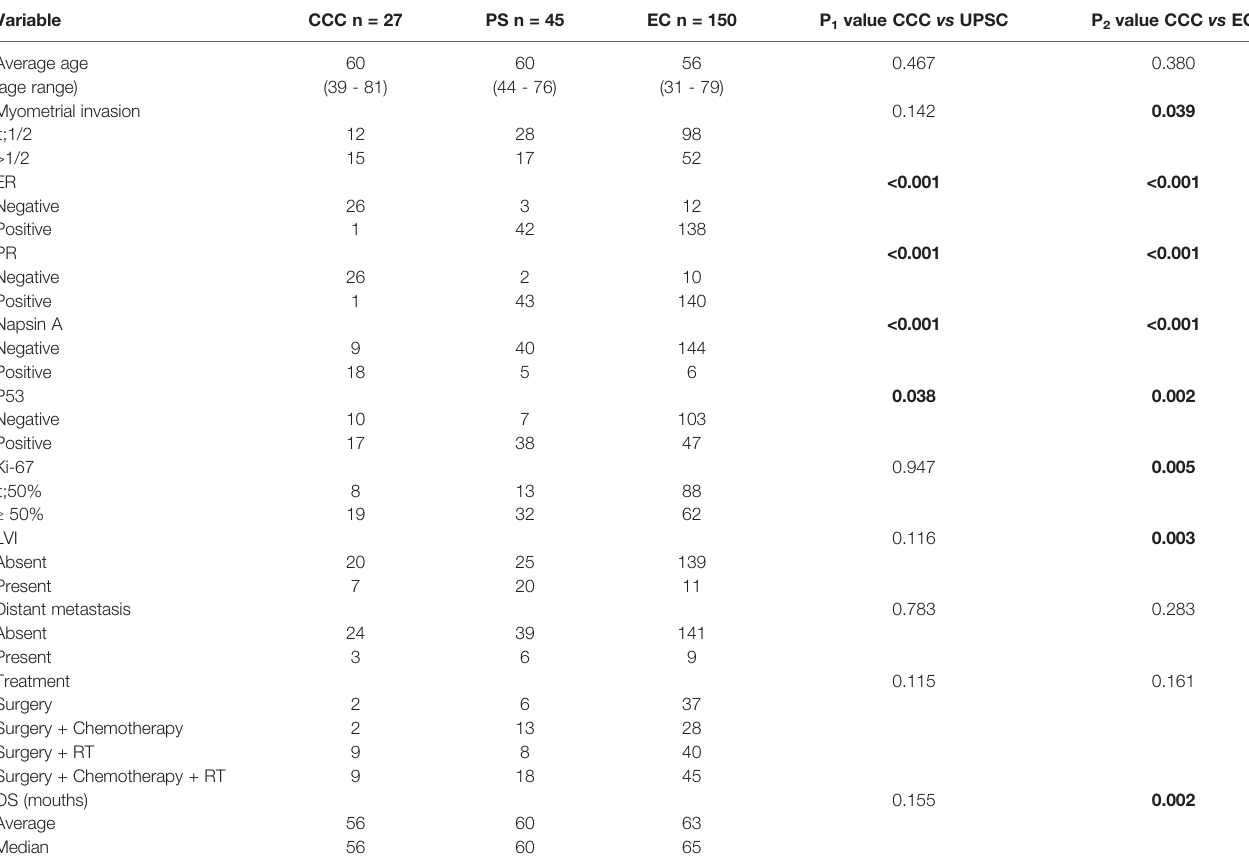
TABLE 4 | Comparative of clear cell carcinoma (CCC) of the endometrium, uterine papillary serous carcinoma (UPSC) and endometrioid carcinoma (EC).